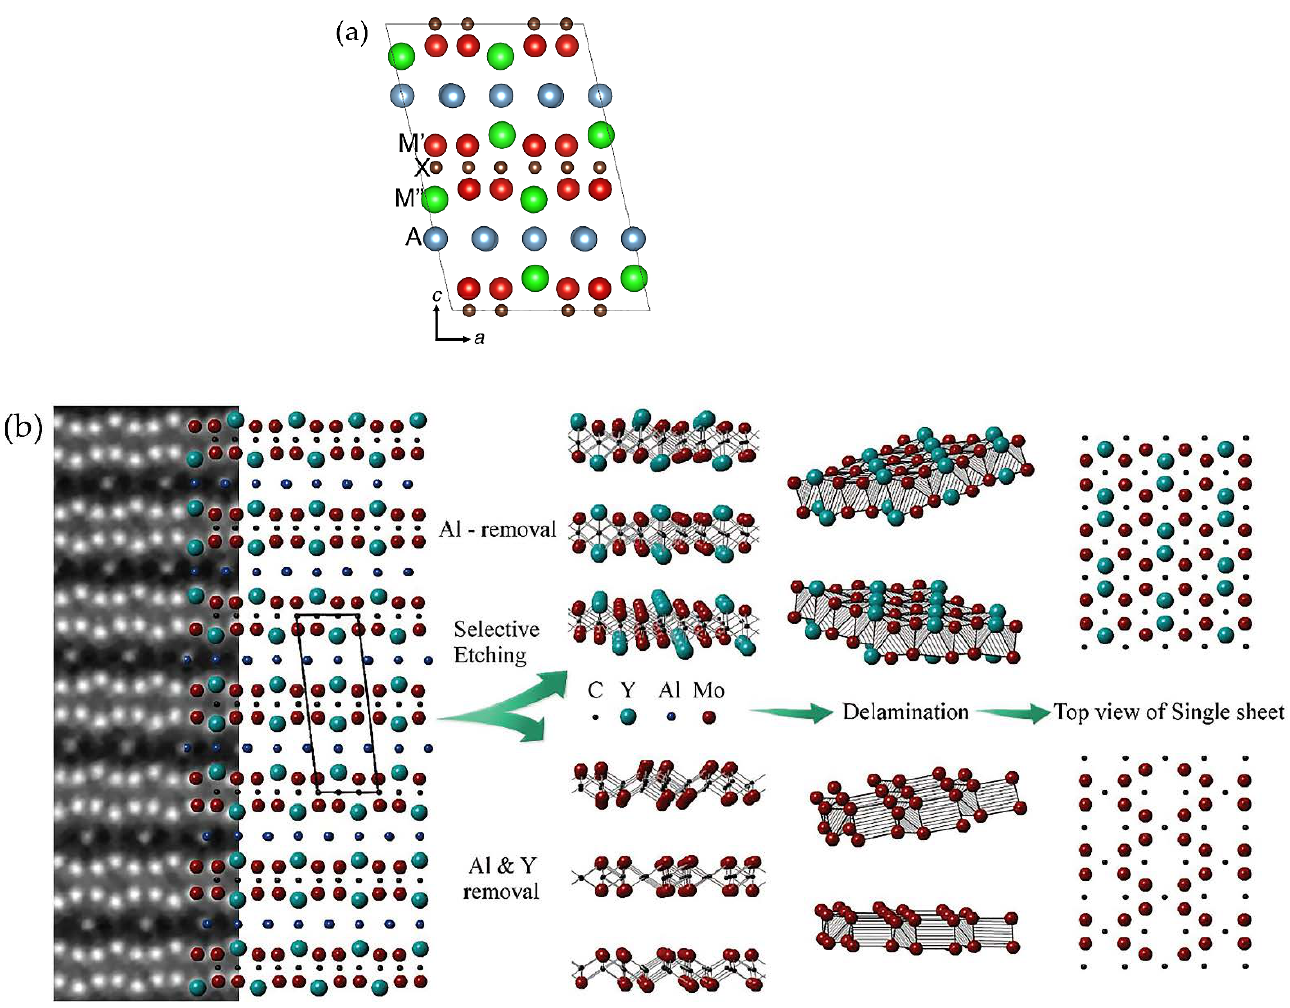
Figure 5. A side view of the crystal lattice cell M 1 2/3 M 2 1/3 ) 2 AX i -MAX phase ( a ); the process of obtaining two types of Mxenes from the i-MAX phases (Mo 2/3 Y 1/3 ) 2 AlC–(M 1 2/3 M 2 1/3 ) 2 X and M 1,33 C ( b ). (Left-to-right) STEM image and schematic representation of the arrangement of phase 211 atoms along the [110] axis prior to etching. Two different structures were obtained by using two protocols for etching the MAX phase: removing only Al (top) or Al + Y (bottom). Top view of a single layer of synthesized Mxene (right). Obtained top view of the corresponding structures. Reprinted with permission from [29,42] 2018 American Physical Society and 2018 John Wiley and Sons.